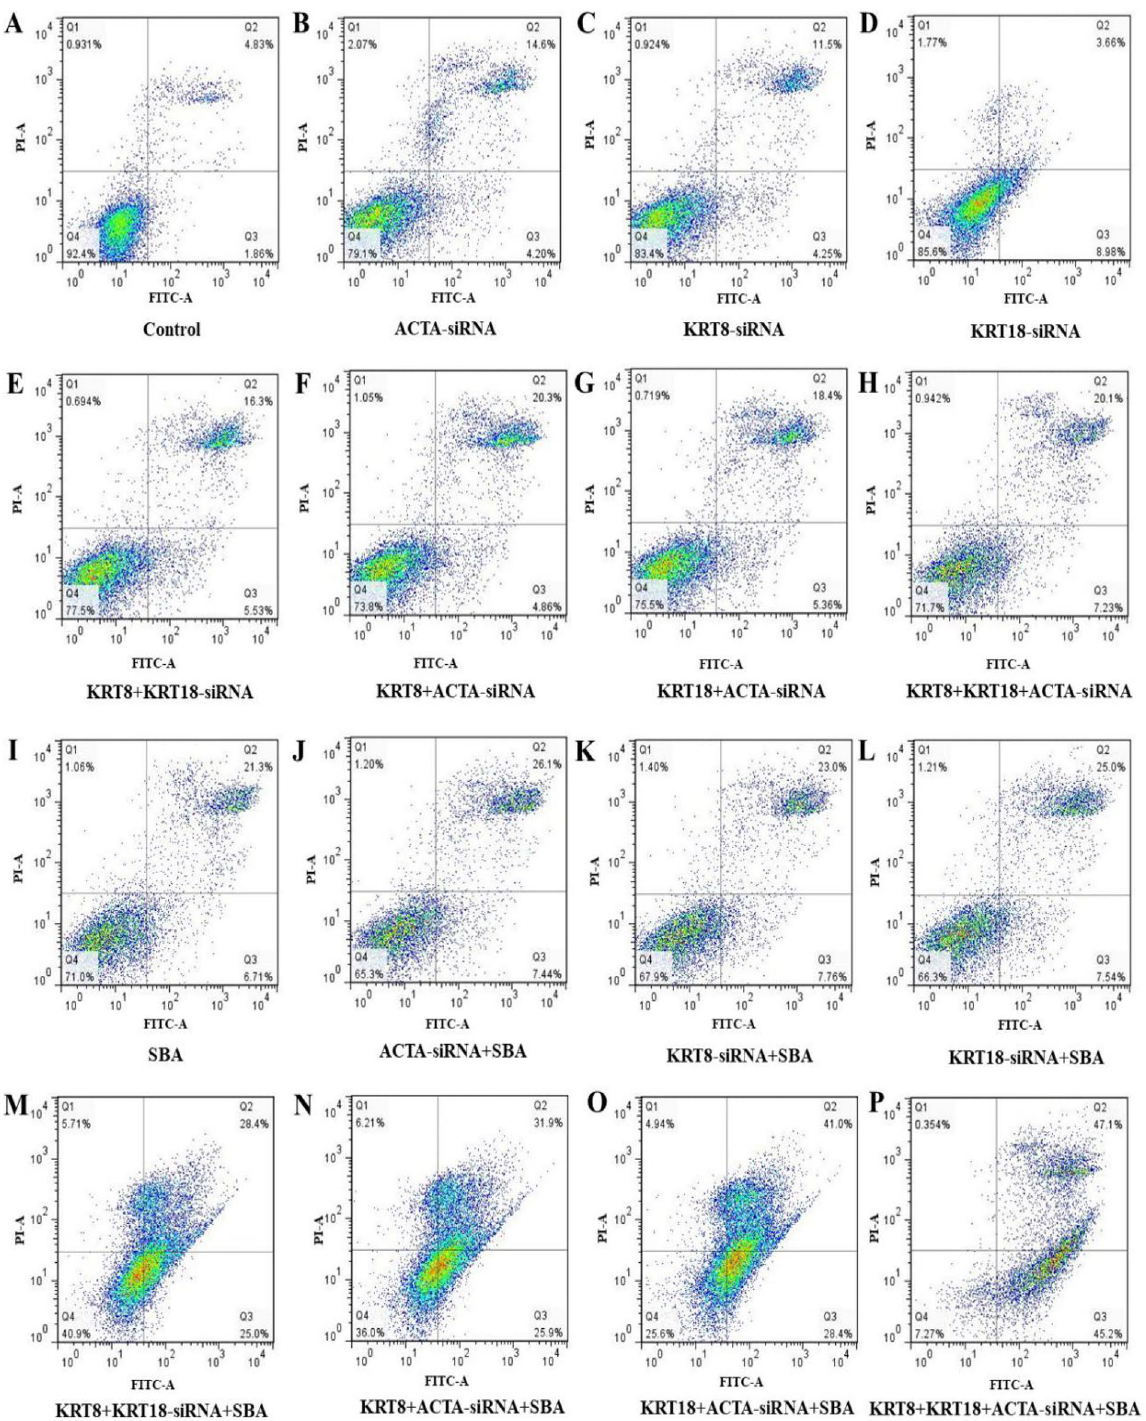
Figure 7. ( A – P ). Roles of different cytoskeleton proteins or their combinations on IPEC-J2 apoptosis rates and SBA-induced apoptosis. The cell apoptotic rates in different treatments for 24 h were determined by FCM and shown in ( A ) Negative control; 0.0 mg/mL SBA treatment; ( B ) ACTA-siRNA treatment; ( C ) KRT8-siRNA treatment; ( D ) KRT18-siRNA treatment; ( E ) KRT8 + KRT18-siRNA treatment; ( F ) KRT8 + ACTA-siRNA treatment; ( G ) KRT18 + ACTA-siRNA treatment; ( H ) KRT8 + KRT18 + ACTA-siRNA treatment; ( I ) Positive control, SBA (2.0 mg/mL) treatment; ( J ) ACTA-siRNA + SBA treatment; ( K ) KRT8-siRNA + SBA treatment; ( L ) KRT18-siRNA + SBA treatment; ( M ) KRT8 + KRT18-siRNA + SBA treatment; ( N ) KRT8 + ACTA-siRNA + SBA treatment; ( O ) KRT18 + ACTA-siRNA + SBA treatment; and ( P ) KRT8 + KRT18 + ACTA-siRNA + SBA